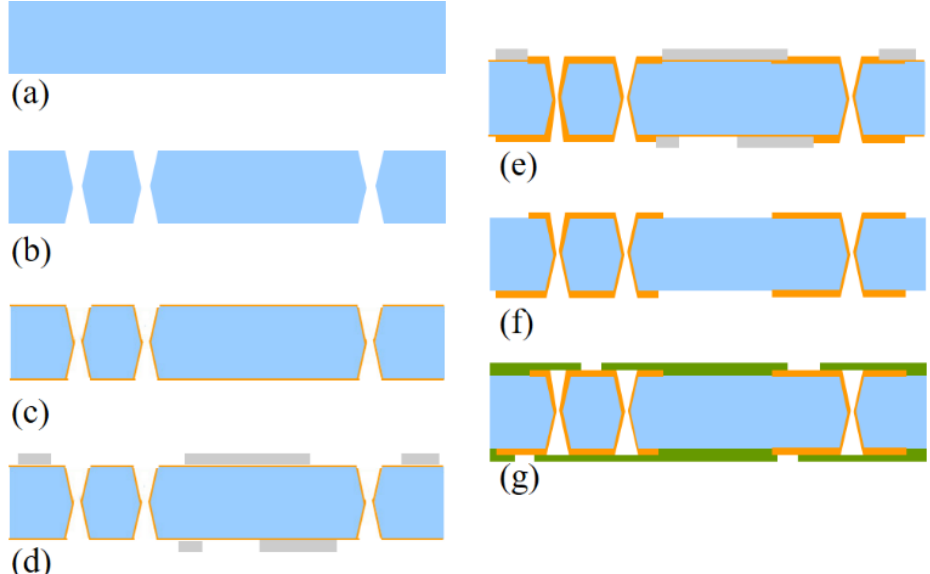
Figure 16. Process flow of TGV conformal filling. ( a ) Incoming glass wafer, ( b ) TGV formation, ( c ) PVD, ( d ) RDL lithography, ( e ) Cu conformal filling, ( f ) photoresist and seed layer by wet etch, ( g ) dry film lamination.